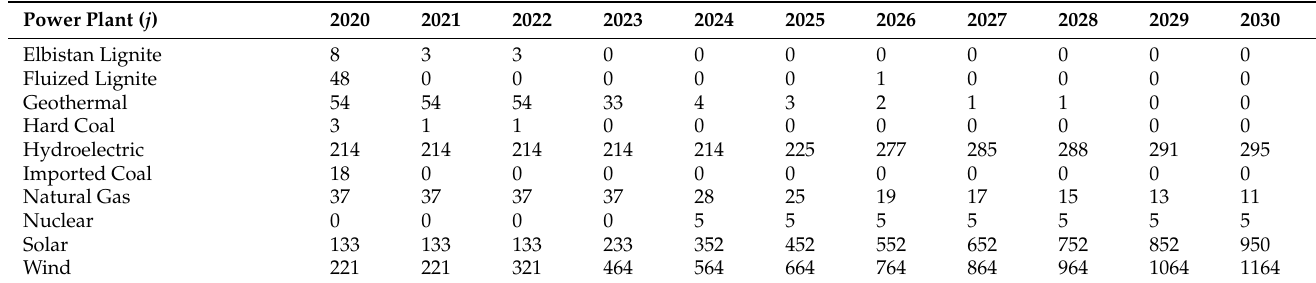
Table 2. Number of Power Plants ( N jt ) for the 2020–2030 Period.